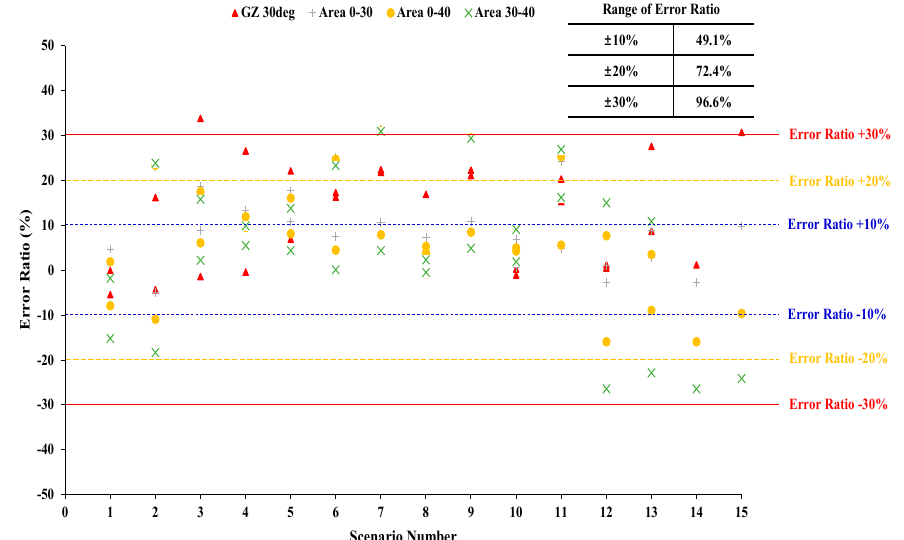
Figure 6. Error ratio of all parameters using empirical formulas. Table 9. Comparison of compliance with IMO intact stability